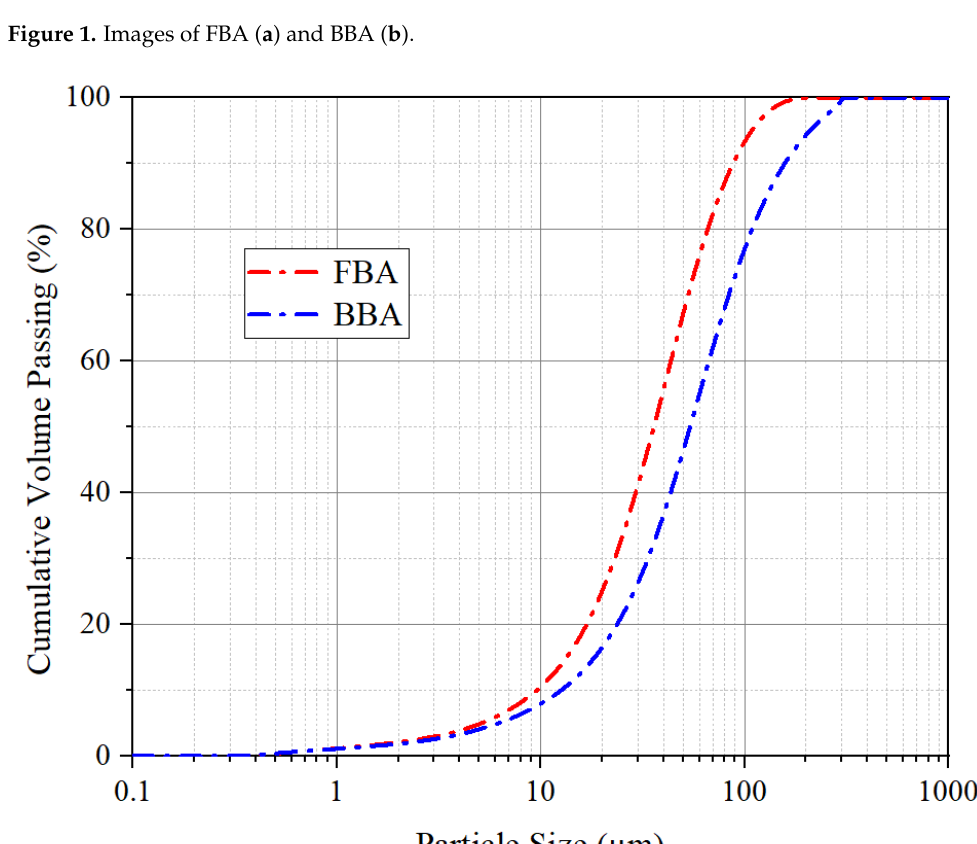
Figure 2. Particle-size distributions of Bas by laser diffraction Figure 2. Particle ‐ size distributions of Bas by laser diffraction method.